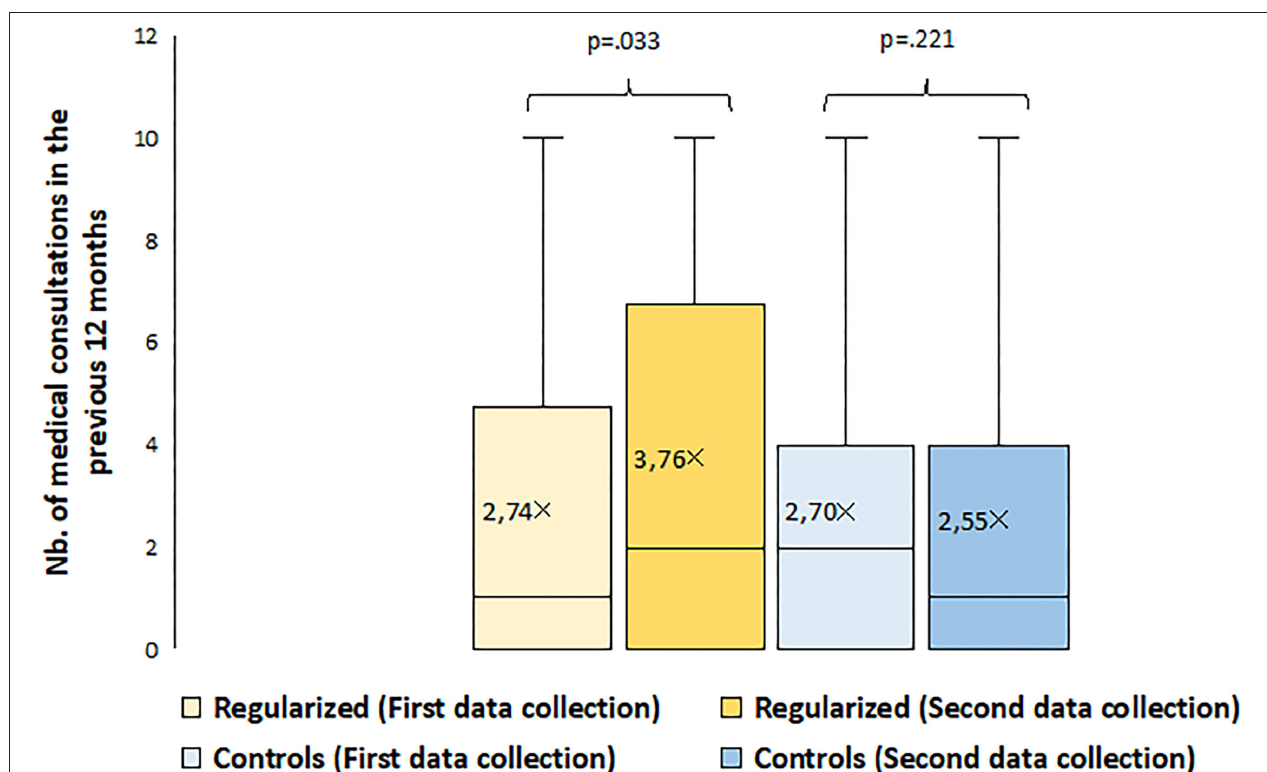
FIGURE 3 | Evolution of participants’ healthcare utilization, stratified by residence status